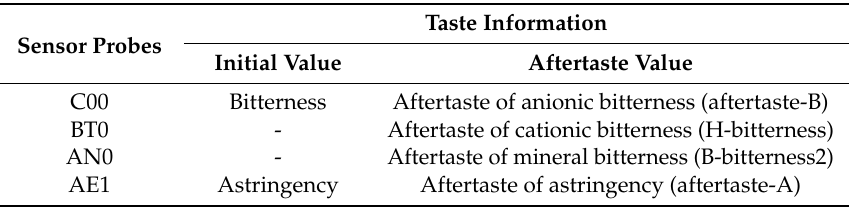
Table 4. Taste information represented by four taste sensors. Taste Information Sensor Probes Aftertaste Value Aftertaste of anionic bitterness (aftertaste-B) Aftertaste of cationic bitterness (H-bitterness) - Aftertaste of mineral bitterness (B-bitterness2) AE1 Astringency Aftertaste of astringency (aftertaste-A) “-“ indicates no relative